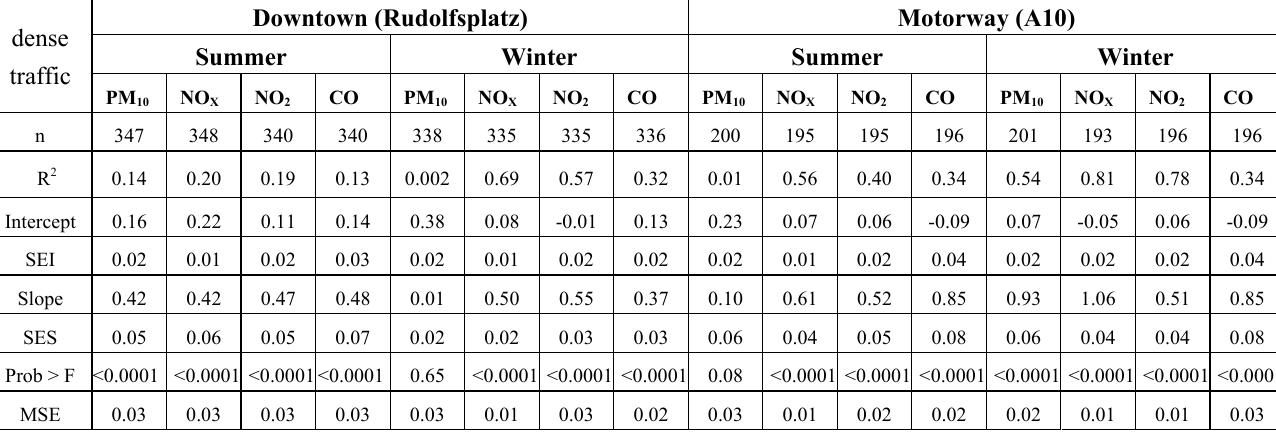
Table 1. Statistics describing the relationship between UFP and the independent variables , NO , NO and CO). Legend: n = sample size; R 2 = for regression line; (PM 10 X 2 SEI = standard error for intercept; SES = standard error for slope; MSE = mean squared error. dense